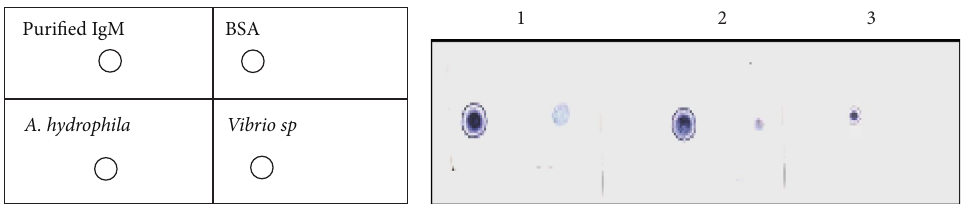
Figure 5: Immunodot assay. 1. Immunoglobulin IgM. 2. Sera. 3.